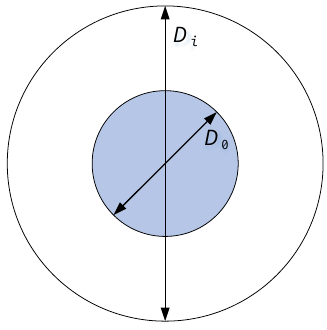
Figure 1. Core-shell model showing diameter of the core ( D 0 ) and the coated particle ( D i ) .